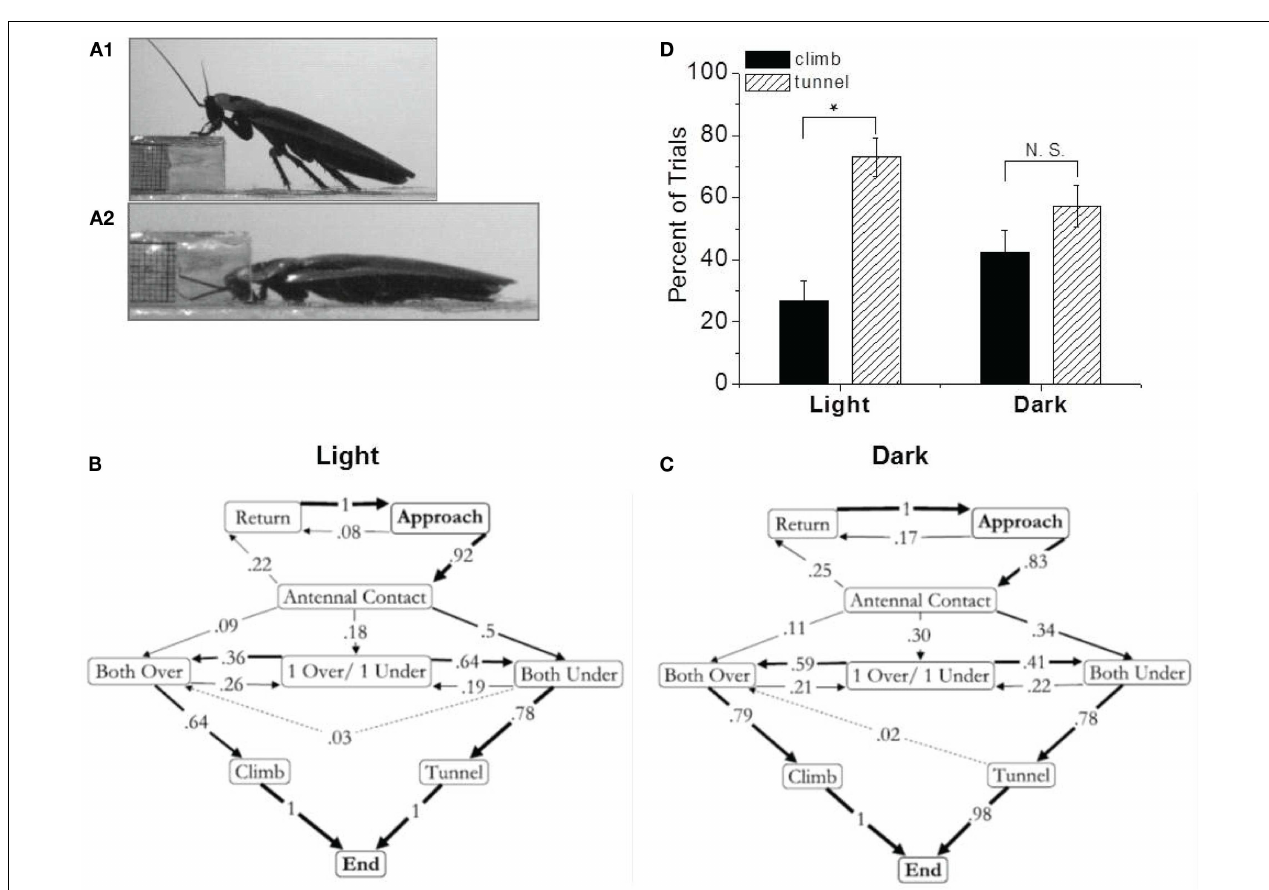
(over/under). (D) Climbing and tunneling in insects presented with a shelf under different ambient lighting conditions. Naïve cockroaches were placed in the experimental arena with an obstacle they could climb over or tunnel under.The light condition represented 56 trials (14 climbs and 42 tunnels).The dark condition represents 61 trials (26 climbs, 35 tunnels).The error bars represent the ± standard deviation ( ± SD; calculated using methods for binomial data). In the light, the climbing and tunneling percentages are significantly different ( p < 0.01, χ 2 test). In the dark, this difference is not significant ( p > 0.5, χ 2 test). From Harley et al.